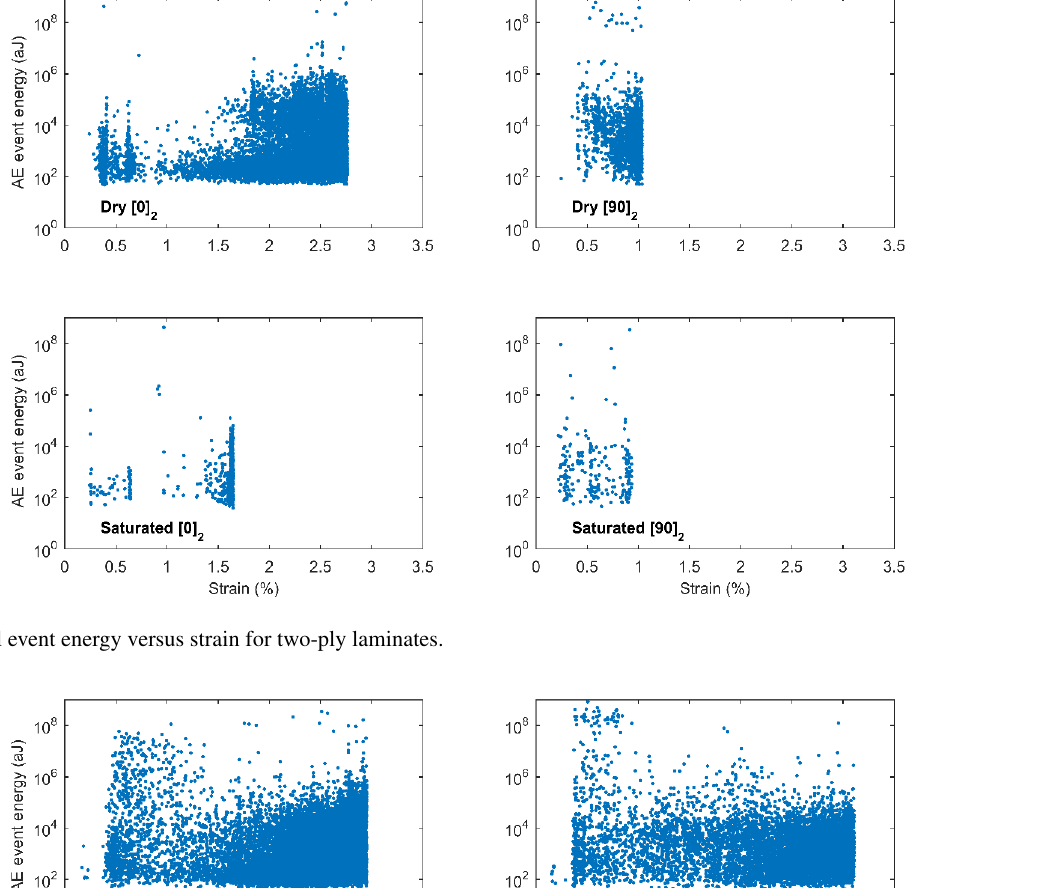
Figure 13. Typical event energy versus strain for two-ply laminates.